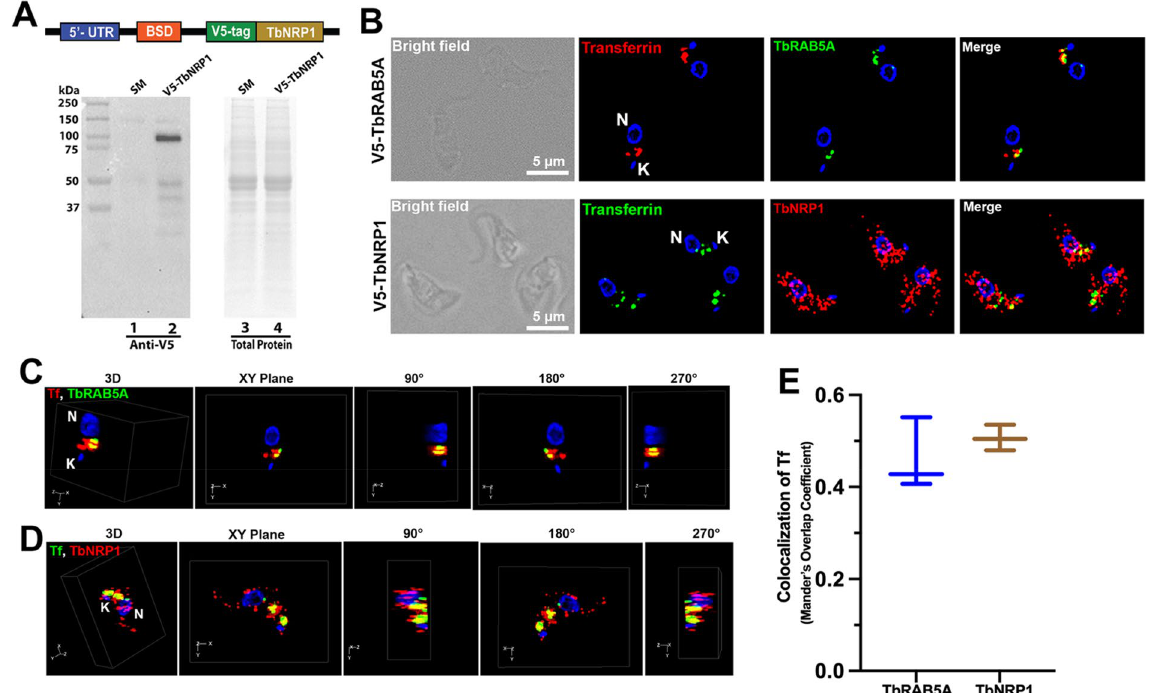
Figure 4. Endocytosed Tf co-localizes with V5-TbNRP1 ( A ) Western blot analysis of a V5-TbNRP1 trypanosome line. Trypanosomes (2 × 10 6 ) were lysed, and proteins were separated by SDS-PAGE (12%). Proteins were transferred to a PVDF membrane that was developed using anti-V5 (rabbit) primary antibody. ( B ) Detection of Tf and intracellular V5-RAB5A or V5-NRP1. Cells were incubated for 2 min with Tf-Alexa594 (25 µg/mL) or Tf-Alexa488 (25 µg/mL) at 37 °C, fixed in PFA and stained with anti-V5 (rabbit) antibody. DAPI was used to detect DNA. Upper panel of images depict location of internalized Tf-AF594 and TbRAB5A. Lower panel of images show internalized Tf-AF488 and TbNRP1. ( C ) and ( D ) represent 3D reconstruction of Z-stack images of Tf and TbRAB5A or Tf and TbNRP1 respectively. ( E ) Graph shows overlap (Mander’s coefficient) of endocytosed Tf with TbRAB5A or TbNRP1. Three hundred cells were analysed from three independent biological samples. K, Kinetoplast; N,